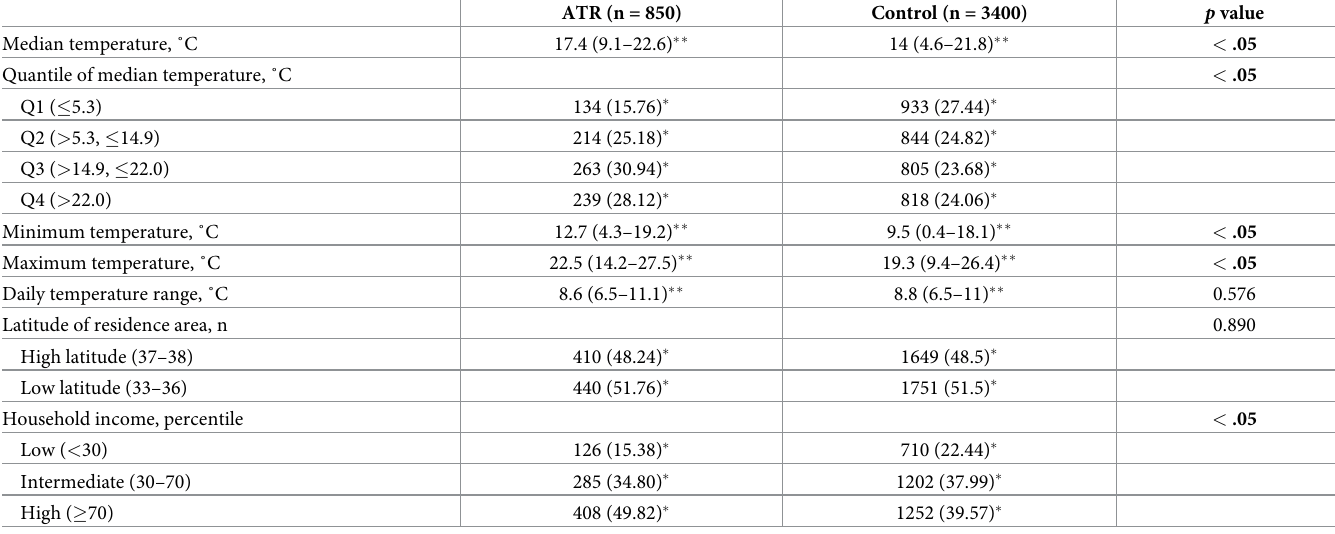
Table 3. Comparative analysis of outdoor temperatures in achilles tendon repair group and randomly selected controls (2002–2015).